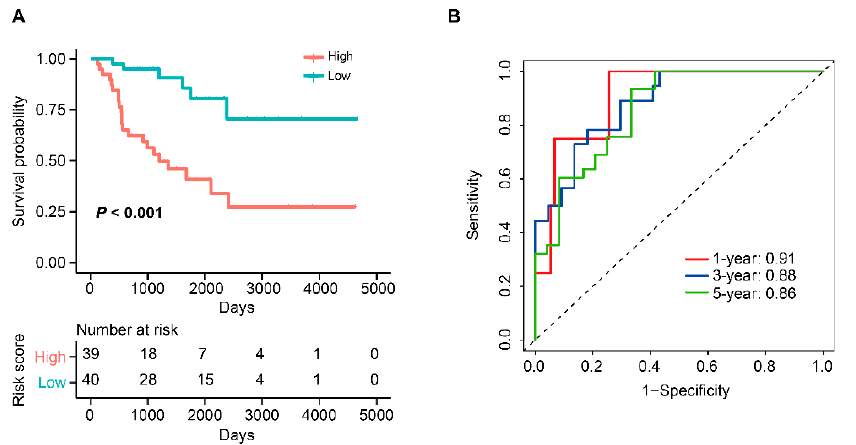
Figure 18. Identification of a novel TME-related signature in TCGA-ACC dataset. ( A ) KM curves of OS for patients in the high- and low-risk groups. ( B )Time-ROC curve to predict the OS at year 1, 3, and 5.